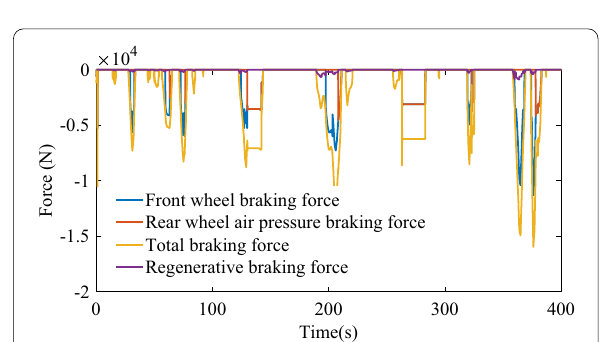
After determining the total braking force, the braking force of the front and rear wheels and the distribution of regenerative braking and pneumatic braking are per- formed according to the distribution strategy mentioned. The simulation results of the distribution of braking force are shown in Figure 11.